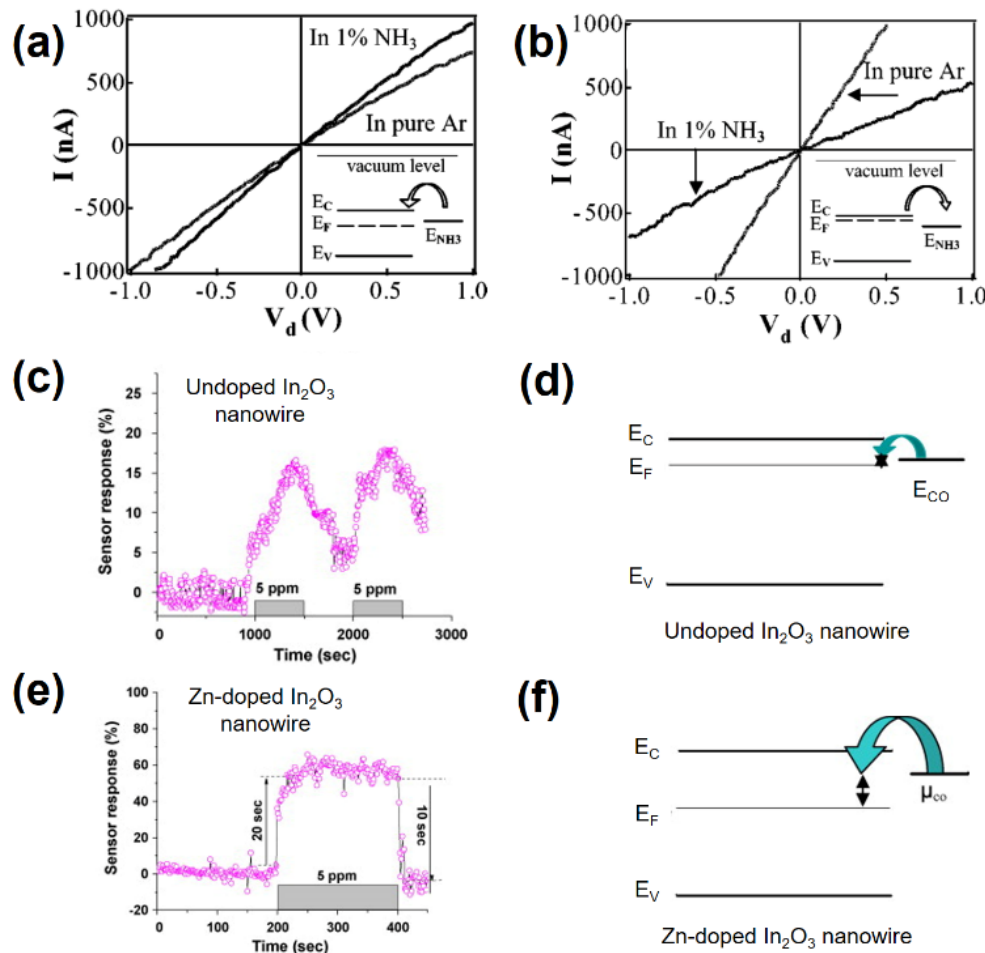
Figure 21. ( a ) I − V curves of heavily doped In 2 O 3 nanowires device before and after exposure to 1% NH3. Inset shows the energy band diagrams of heavily doped In 2 O 3 and NH 3 molecules; ( b ) I − V curves of lightly doped In 2 O 3 nanowires device before and after exposure to 1% NH 3 . Inset shows the energy band diagrams of lightly doped In 2 O 3 and NH 3 molecules. Reprinted from reference [340] with permission from the American Institute of Physics (AIP) Publishing; ( c ) sensing response of Undoped In 2 O 3 nanowires ( d ) Energy band diagrams of undoped In 2 O 3 and CO molecules; ( e ) sensing the response of Zn-doped In 2 O 3 nanowires; ( f ) energy band diagrams of Zn-doped In 2 O 3 and CO molecules. Reprinted from reference [341] Copyright 2010 Elsevier.